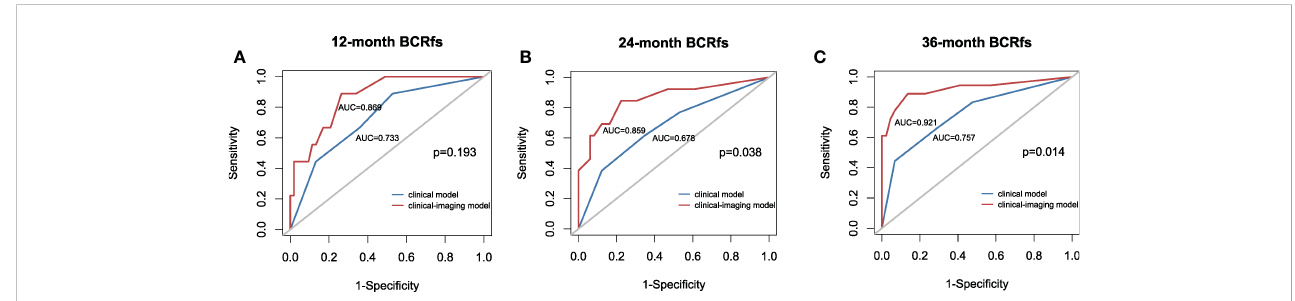
FIGURE 3 Receiver operating characteristic (ROC) curve with the clinical model and clinical-imaging model used for predicting the (A) 12-month BCR-fs, (B) 24- month BCR-fs and (C) 36-month BCR-fs. The clinical imaging model had higher AUCs than the clinical model in predicting the 12-month, 24-month and 36-month BCR-fs. AUC, area under the curve; BCR-fs, biochemical recurrence-free survival.